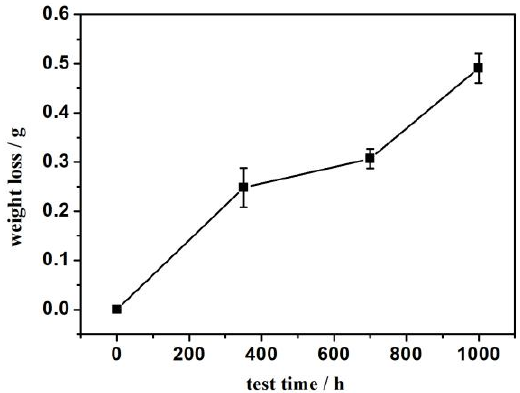
Figure 10. Weight loss of